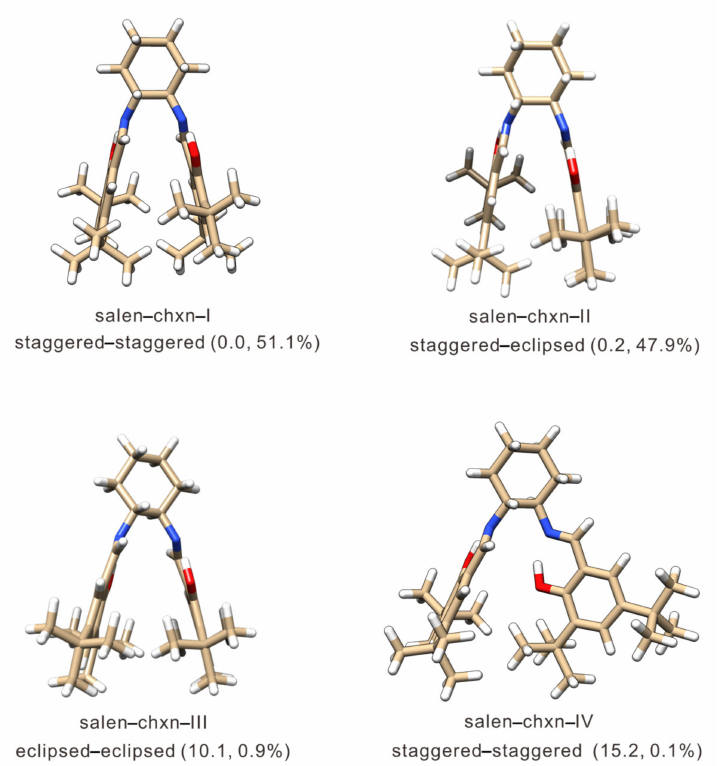
Figure 2. Optimized geometries of the four low energy salen-chxn ligand conformers identified by the CREST search and optimized at the B3LYP-D3BJ/def2-TZVP level of theory with the PCM of CDCl 3 . The relative free energies in kJ mol − 1 and the Boltzmann percentage abundances at 298 K are provided in the brackets. The blue and red colors represent the nitrogen and oxygen atoms, respectively, whereas the white color is for the hydrogen atoms, and the carbon frame is in the ginger